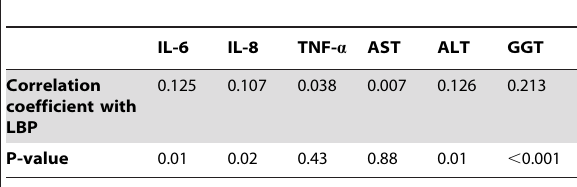
Table 5. Correlation between serum lipopolysaccharide- binding protein (LBP) concentrations and concentrations of proinflammatory cytokines and liver